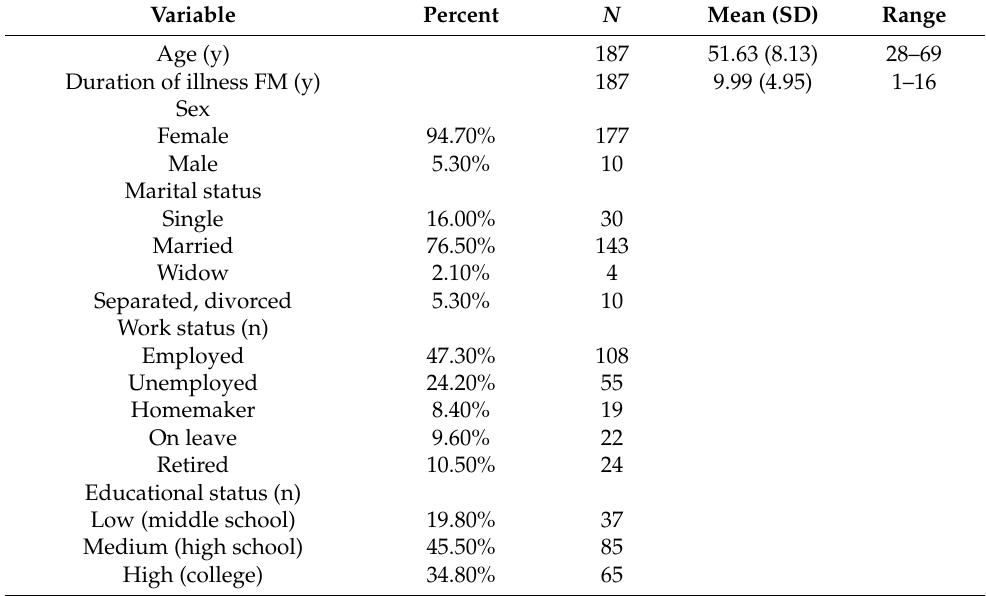
Table 1. Characteristics of the sample ( N = 187).